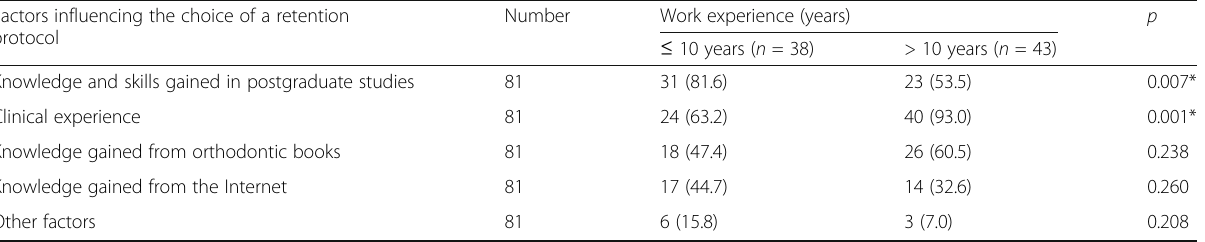
Table 5 The orthodontists who used a retention protocol based on factors according to the length of their work experience Factors influencing the choice of a retention